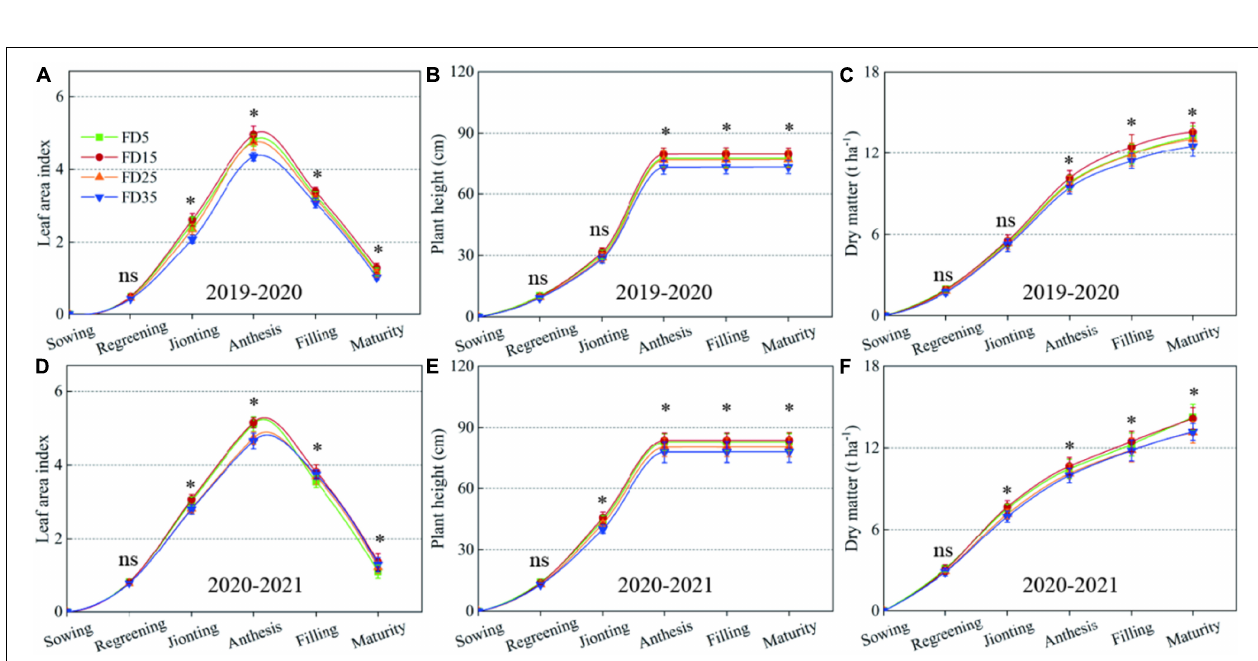
FIGURE 10 | Leaf area index (A,D) , plant height (B,E) and dry matter (C,F) of winter wheat in 2019–2020 and 2020–2021. FD5, fertilizer application at a depth of 5 cm; FD15, fertilizer application at a depth of 15 cm; FD25, fertilizer application at a depth of 25 cm; and FD35, fertilizer application at a depth of 35 cm. The vertical bars stand for standard deviation. ns, no significant difference; ∗ , significant at P < 0.05; ∗∗ , significant at P < 0.01.